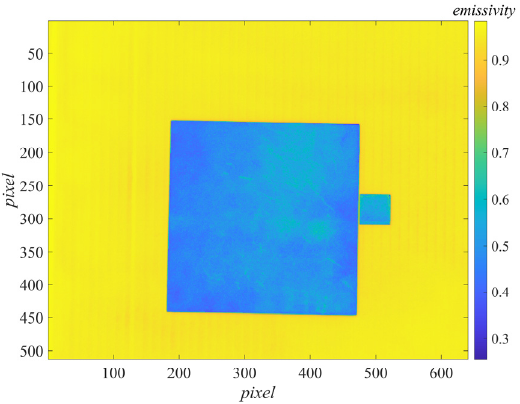
Figure 10. Measured emissivity image by the energy method.